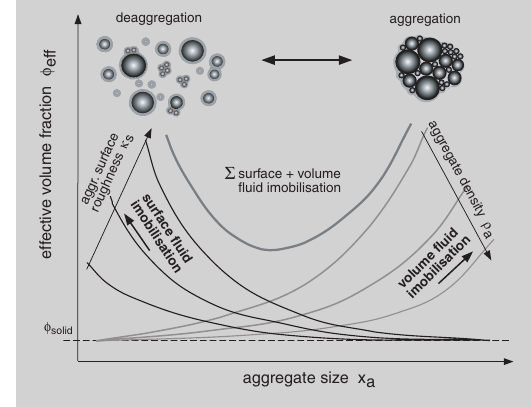
Figure 1: aggregationdeaggregation Immobilization of fluid at surfaces (SIF) or in the volume (VIF) of particles or particle aggregates with respect to aggregation and